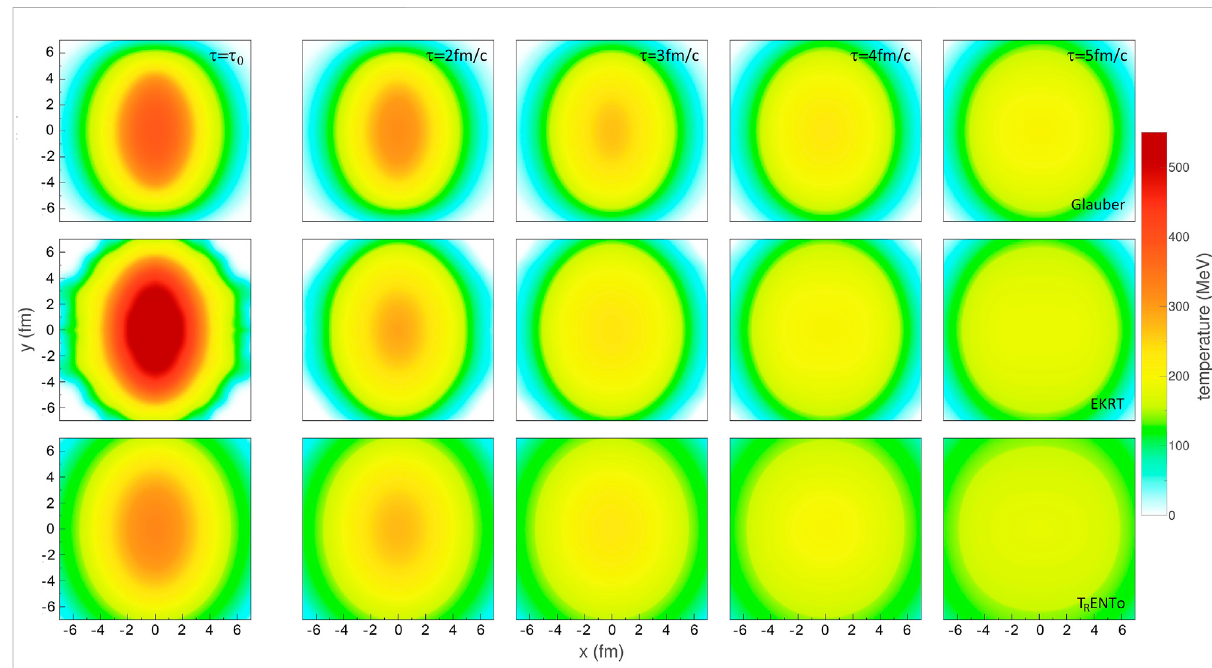
FIGURE 5 Temperature distribution (Pb + Pb collision, 30 – 40% centrality, mid-rapidity) for different medium evolution models, at time (from left to right) τ = τ fi vefm/ c , representedbycolour mapping.First row: “ Glauber ” , τ 0 ,2,3,4and 1.16 fm. Note that distributions in the fi rst column correspond to different